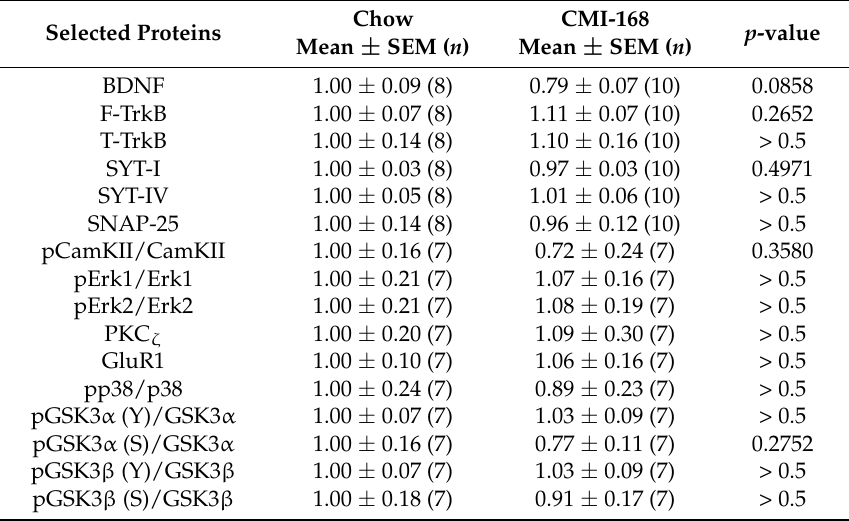
Figure 6. Effects of six-week CMI-168 dietary supplementation on the hippocampal expression or phosphorylation levels of the neuroplasticity-related protein in mice. ( A ) Representative Western blot analysis of hippocampal lysates from Chow- and CMI-168-supplemented mice probed with BDNF, F-TrkB, T-TrkB, SYT-I, SYT-IV and SNAP-25. ( B ) Representative Western blot analysis of hippocampal lysates from Chow- and CMI-168-supplemented mice probed with pCamKII, CamKII, pErk, Erk, PKC ζ , GluR1, pp38, p38, pGSK3 (Y), pGSK3 (S) and GSK3. Table 2. Quantified results (relative expression) of immunoblotting.